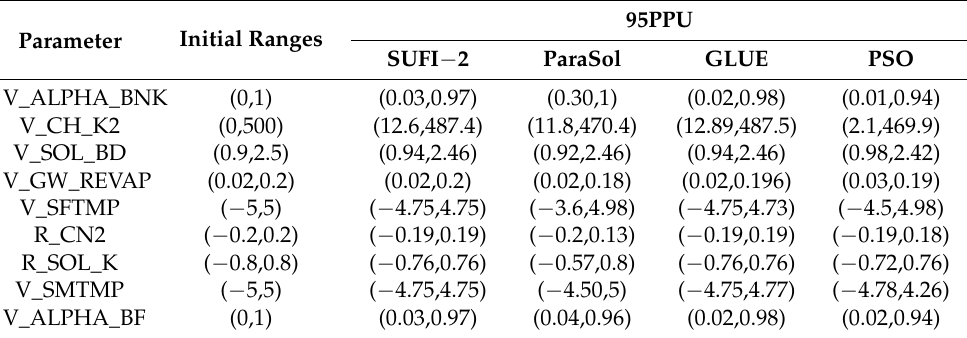
Table 7. Comparison of initial ranges and 95PPU of parameter groups obtained by SUFI-2, ParaSol, GLUE, and